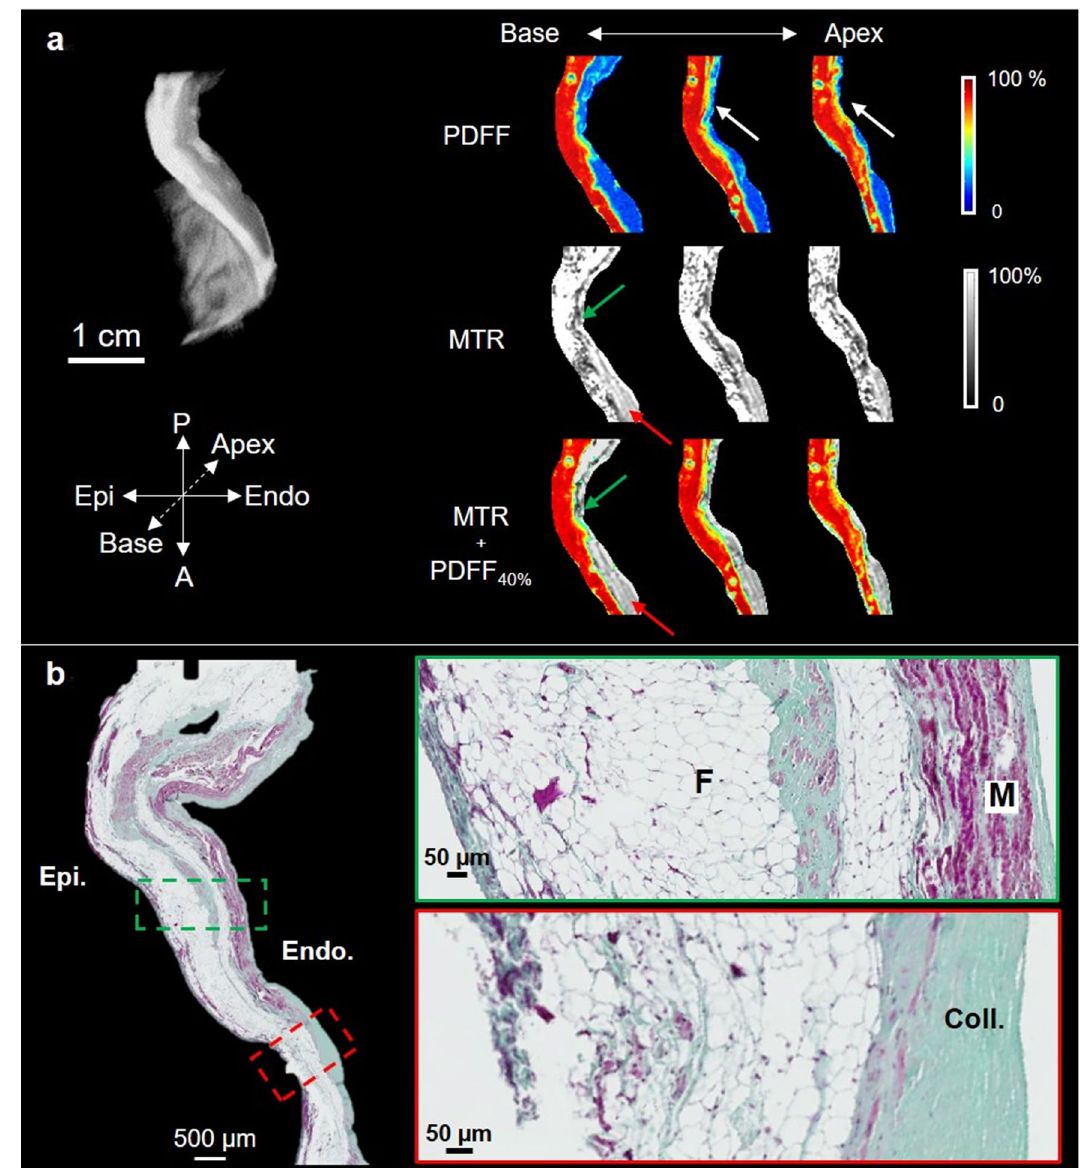
Figure 6. RV free wall subsample of the ARVC heart. Axial ( a ) view of the RV free wall cut sample (2 × 1.5 × 1 cm 3 ). PDFF with epicardial fat contact to the myocardium (white arrows), MT ratio (MTR) and MTR with fat > 40% overlaid (MTR + PDFF 40% ) are presented with area of concentrated (red arrows) and spread (green arrows) fibrosis. All the MRI slices are 200 µm thick and separated by 1 mm. Corresponding histological slices ( b ) stained with Masson’s trichrome are also shown and zoomed regions (green and red dashed rectangles) are displayed. Muscle (M), fat (F) and collagen (Coll.) are visible. The myocardium is filled with